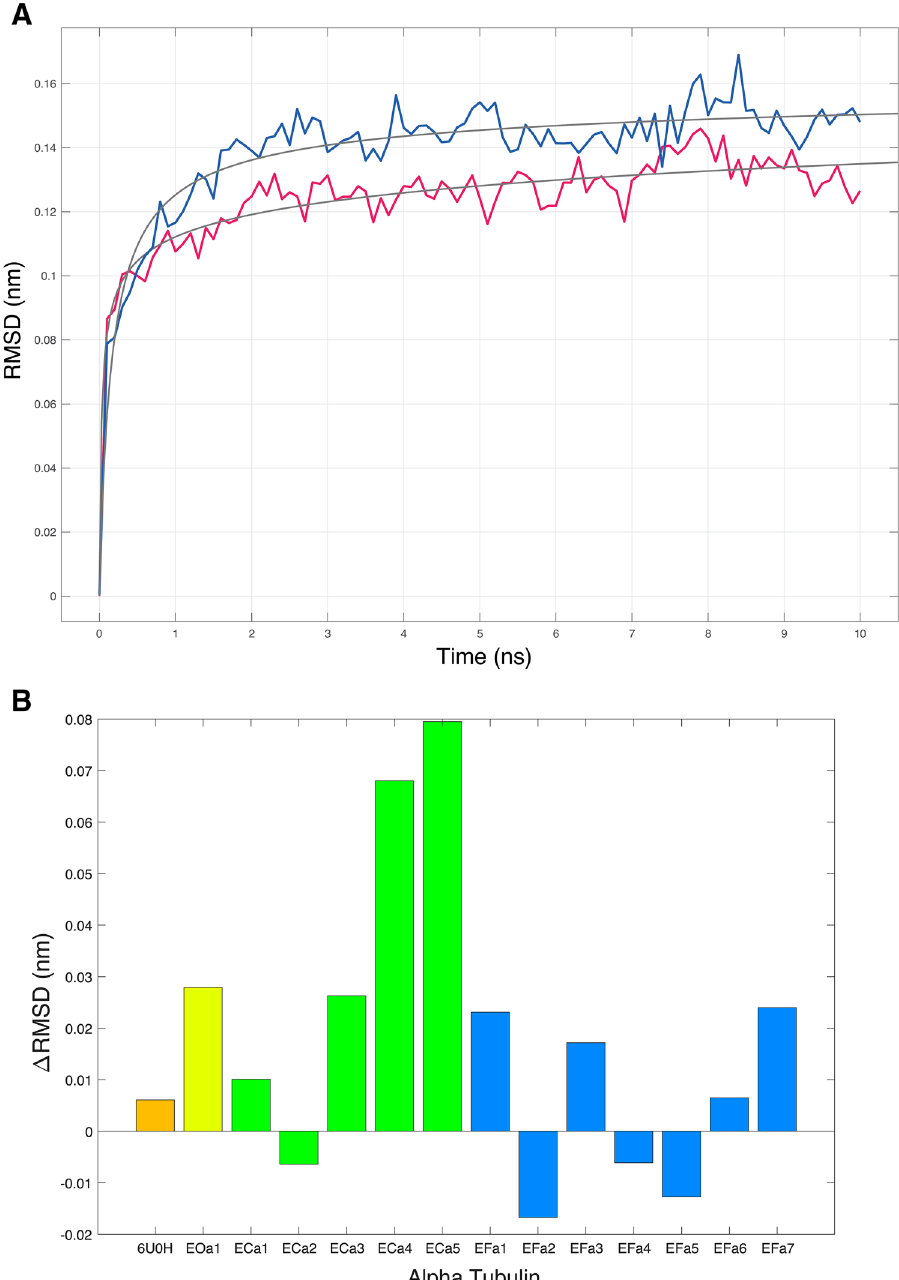
Figure 3. ( A ) trajectories data as backbone RMSDs for E. focardii α-tubulin isotype 2, for the first 10 ns, at 27 °C (red) and at 4 °C (blue). ( B ) the bar plot shows ΔRMSD values for each α-tubulin of E. focardii (blue), E. crassus (green), E. octocarinatus (yellow) and T. thermophila (6U0H, orange; ATU1 in Fig. 2) calculated as the difference between the RMSD max at 27 °C and the RMSD max at 4 °C (see "Materials and methods"